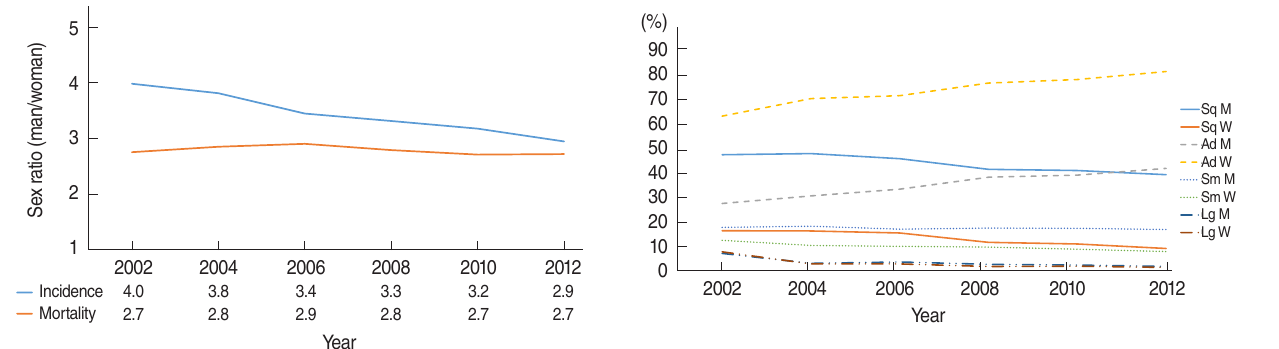
Figure 1. Trends of sex ratios in incidence and mortality rates of lung cancers in Koreans during 2002 and 2012. Source from Korean Statistical Information Service (www.kosis.kr); Korea Central Cancer Registry (www.ncc.re.kr).